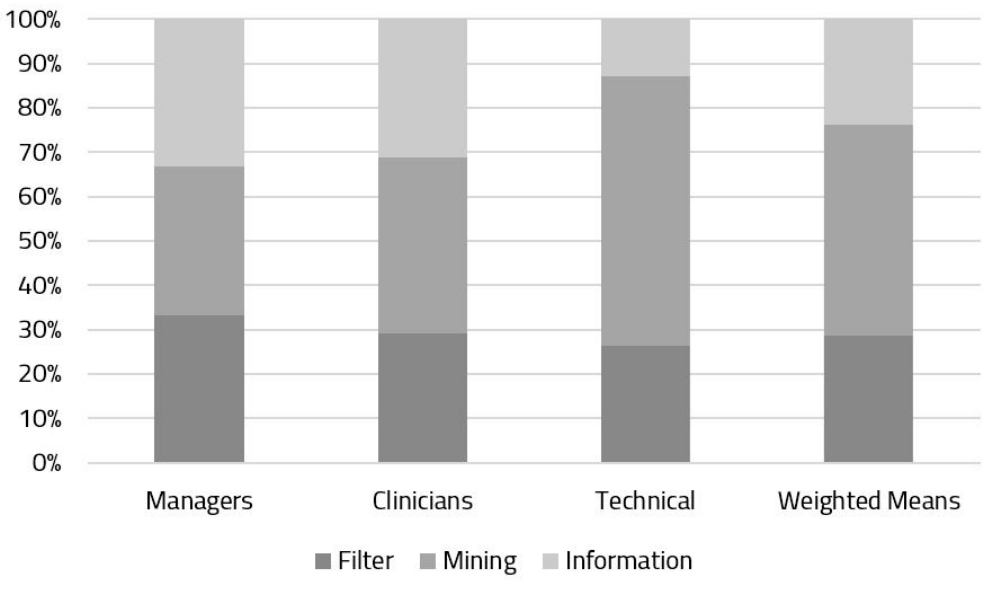
Figure 4. Assigned priorities for the functional